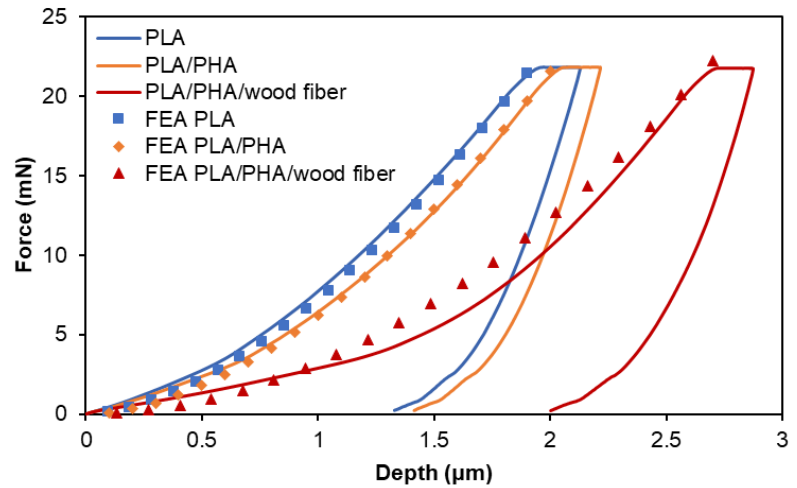
Figure 11. Comparison of load – depth nanoindentation curves of PLA composites along with the FEA-generated verification results. FEA-generated verification results.